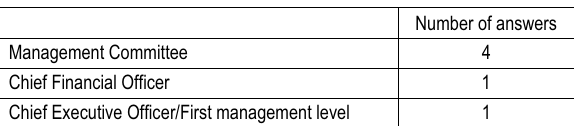
Table 15. Answer to the question: distribution of the